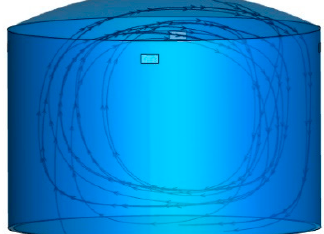
Figure 5. Streamtraces inside the tank for the floating-deck height of 2.82 m.